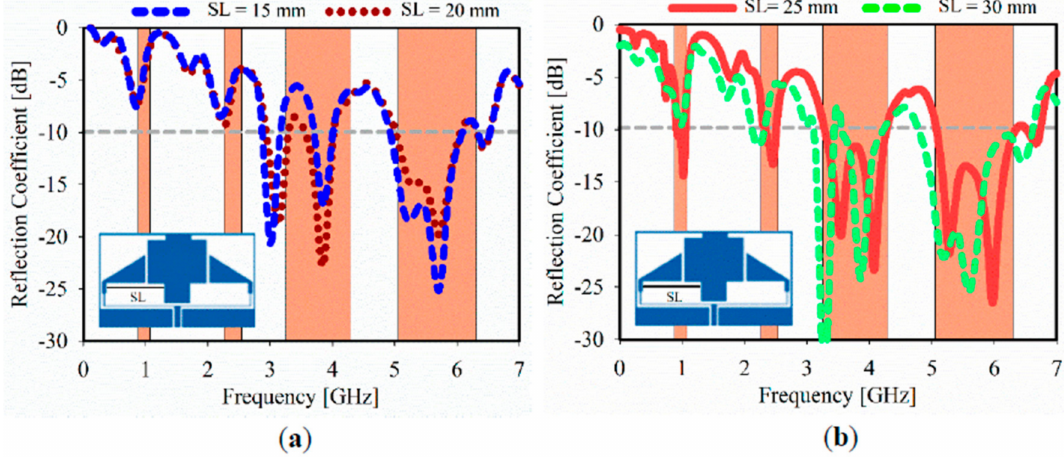
Figure 10. Simulated reflection coe ffi cient for di ff erent slot length at: ( a ) SL = 15 mm, SL = 20 mm; ( b ) SL = 25 mm, and SL = 30